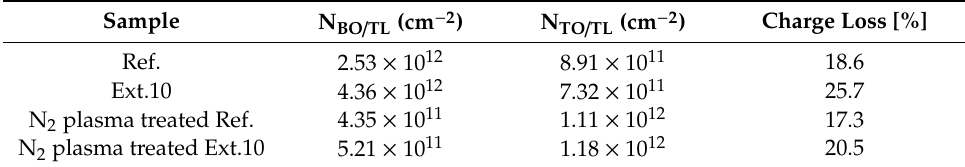
Figure 5. Measurement results of program and data retention characteristics of the fabricated devices ( a ) without N 2 plasma treatment and ( b ) with treatment. Here, the retention properties were measured after baking at 300 °C for 2 h. Table 1. Extracted trap density based on C–V analysis. Here, N BO / TL and N TO / TL are the interface trap density of blocking oxide / trapping layer and tunneling oxide / trapping layer,